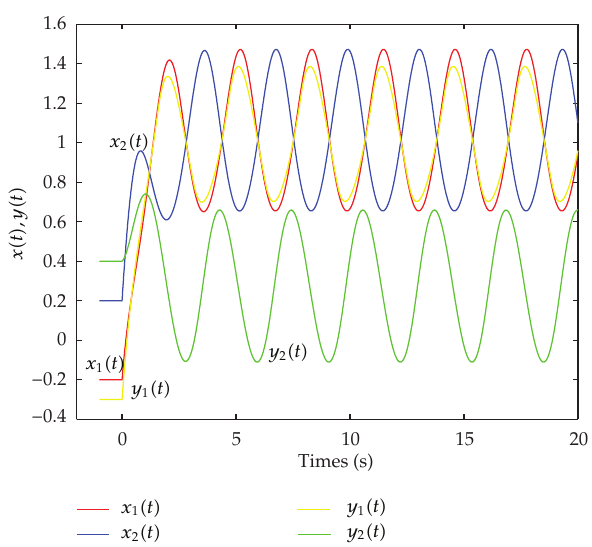
Figure 1: Transient response of state variable x 1 (cid:6) t (cid:7) , x 2 (cid:6) t (cid:7) , y 1 (cid:6) t (cid:7) and y 2 (cid:6) t (cid:7) .